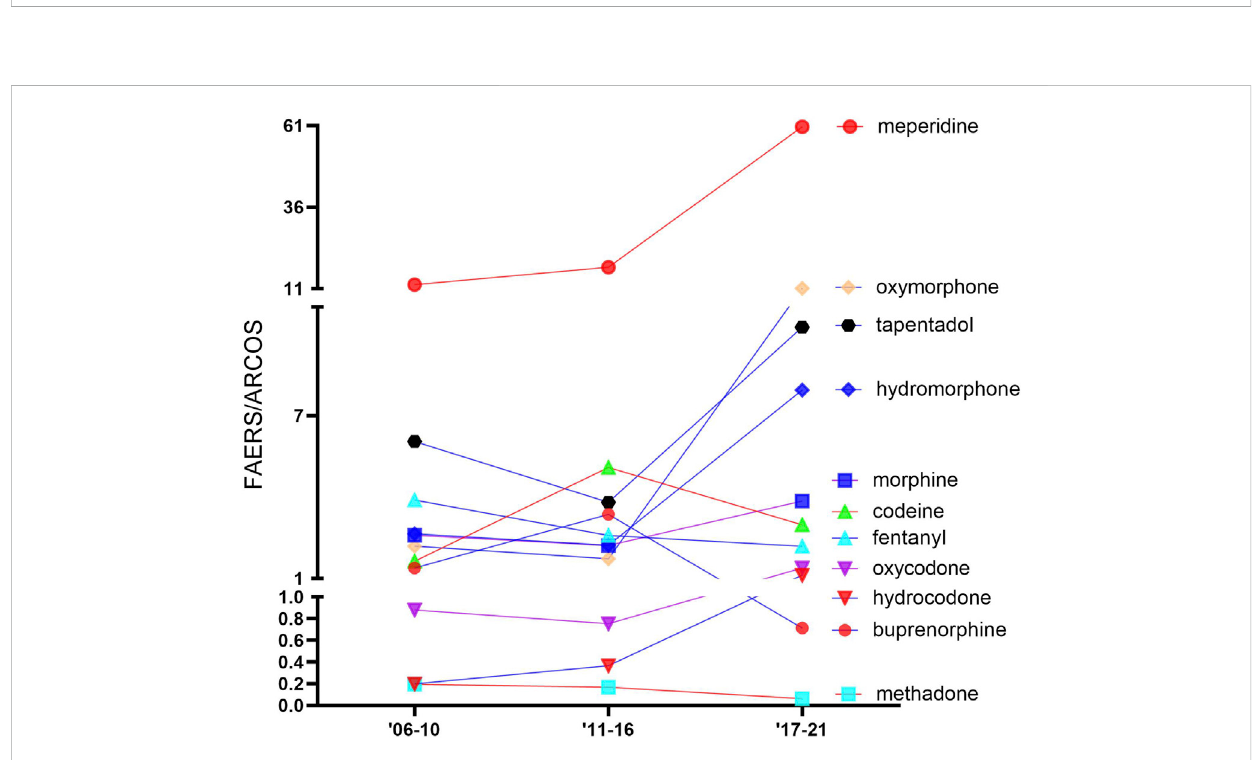
FIGURE 3 Ratio of the percentage of adverse drug events, as reported by the US Food and Drug Administration ’ s Adverse Events Reporting System relative to the percent of distribution as reported by the Drug Enforcement Administration ’ s Automated Reports and Consolidated Orders System database for the 11 prescription opioids over time. Values greater than 1.0 are over-represented, and values less than 1.0 are